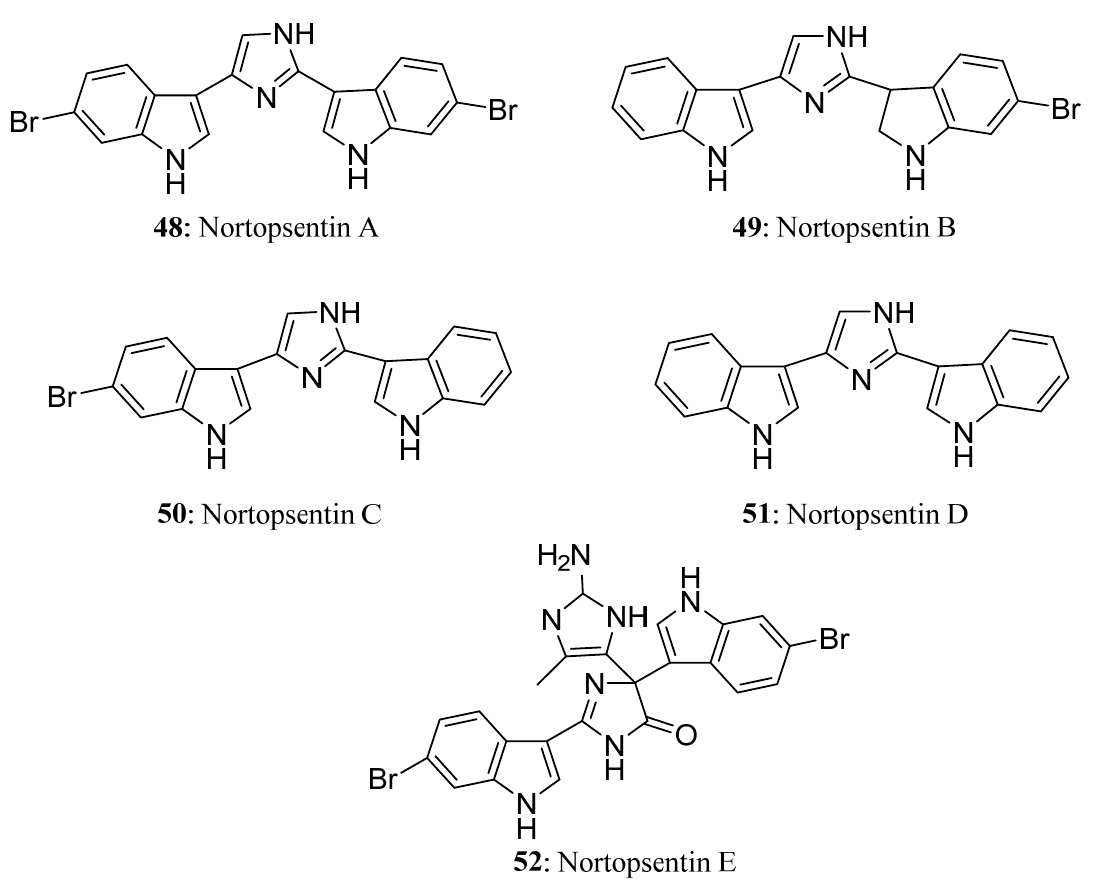
Figure 10. Structures of nortopsentin A–E ( 48 – 52 ).